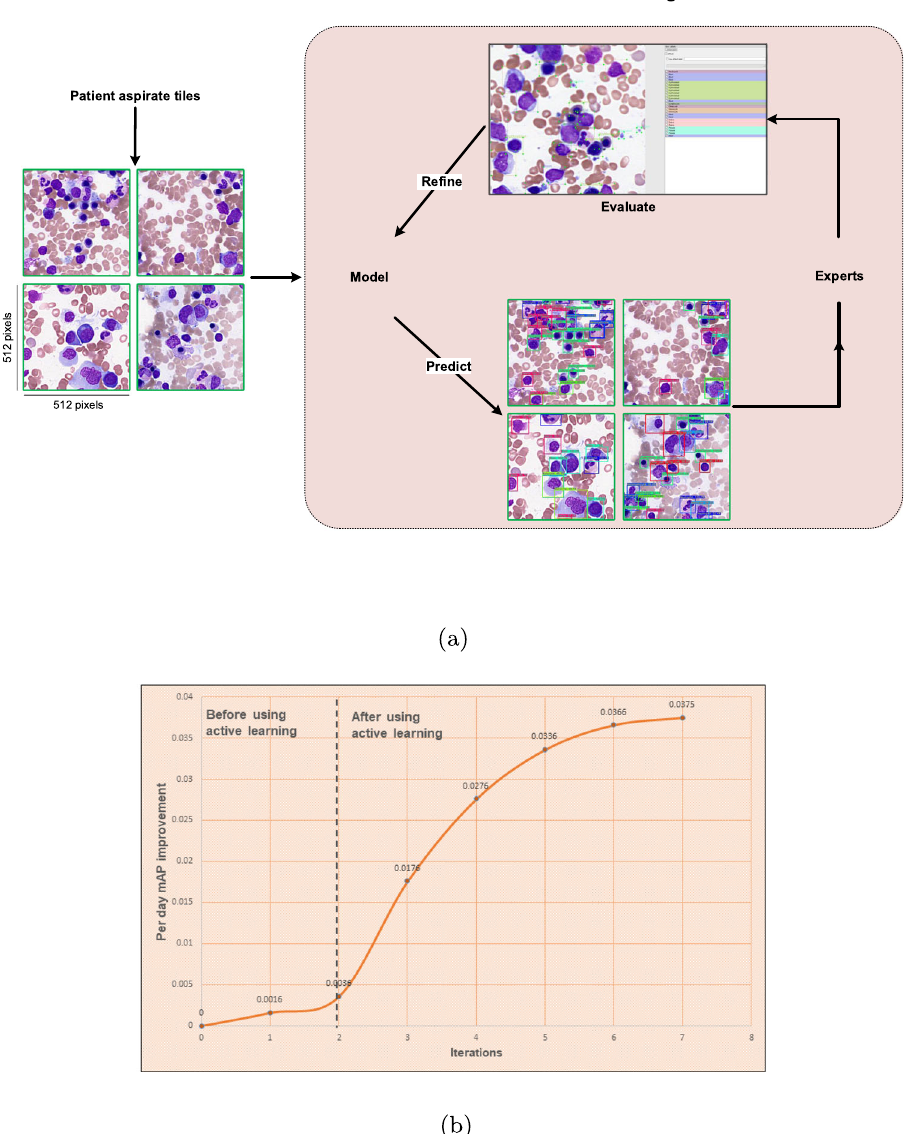
process. b After using the active learning approach, per day mean average precision (mAP) has been improved drastically. Here in each iteration, 250